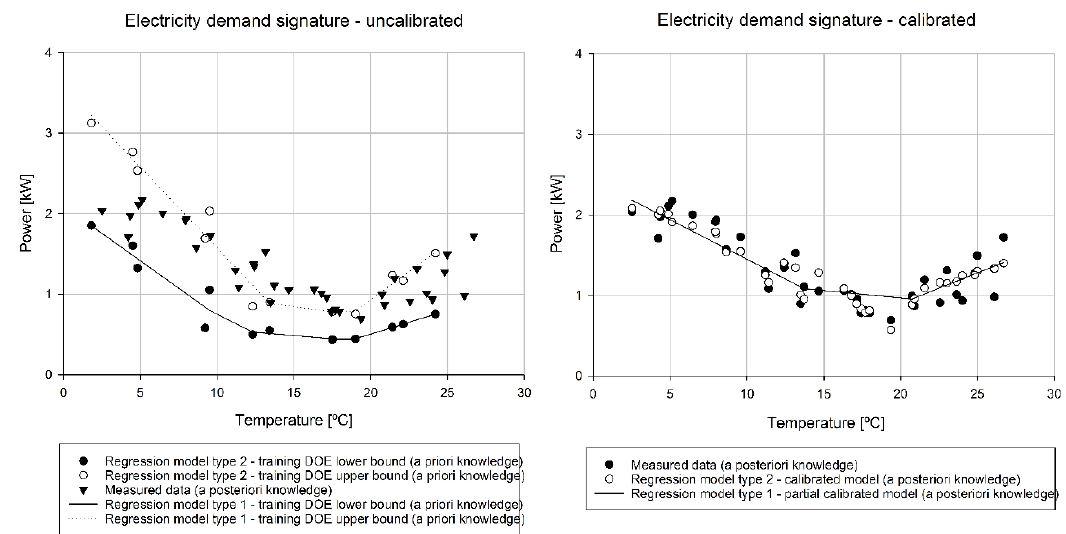
Figure 4. Monitoring the electricity demand—overall analysis of a priori and a posteriori knowledge from uncalibrated to calibrated models.